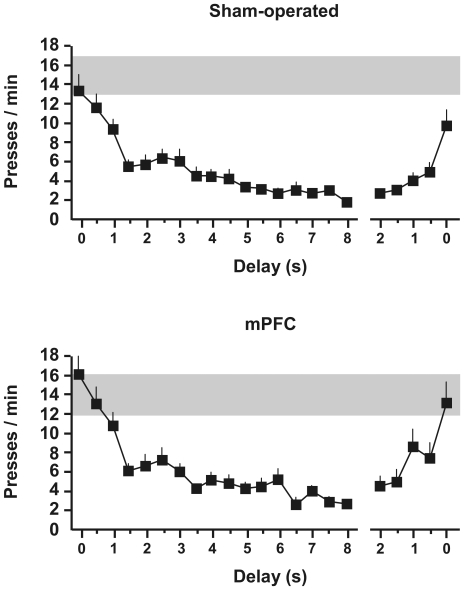
Adaptation to contiguity changes in sham and mPFC-lesioned rats.Upper panel: Sham, control rats. Lower panel: PFC: rats with lesions of the medial prefrontal cortex. Data points represent average lever-pressing rate across blocks of fixed delay (mean + s.e.). Delay between lever press and reward was increased by 0.5 s after each block of four rewards. Last data points show the recovery of responding with short delays during test on the next day. Grey area shows range of values observed in group no-delay across the whole session (computed over blocks of four rewards).